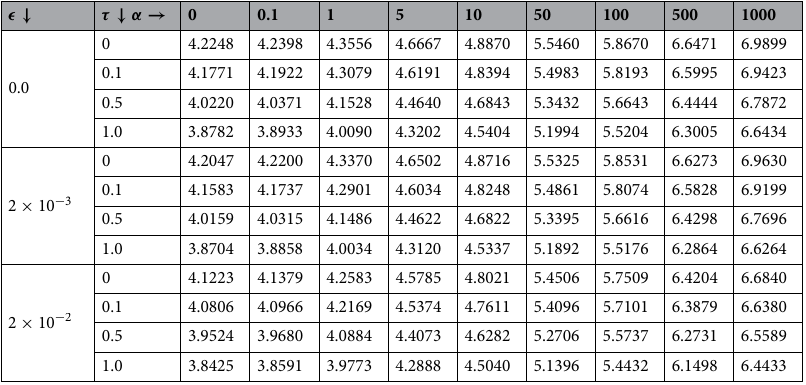
Table 1. Floating electric potential φ f (α , τ , ǫ)